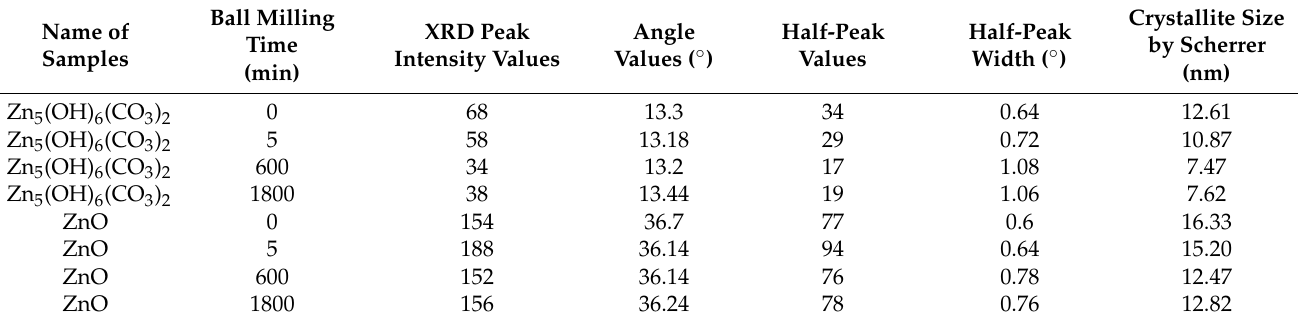
Figure 1. ( a ) XRD patterns of the precursors after different ball milling times; and ( b ) XRD of the products calcined at 300 °C.